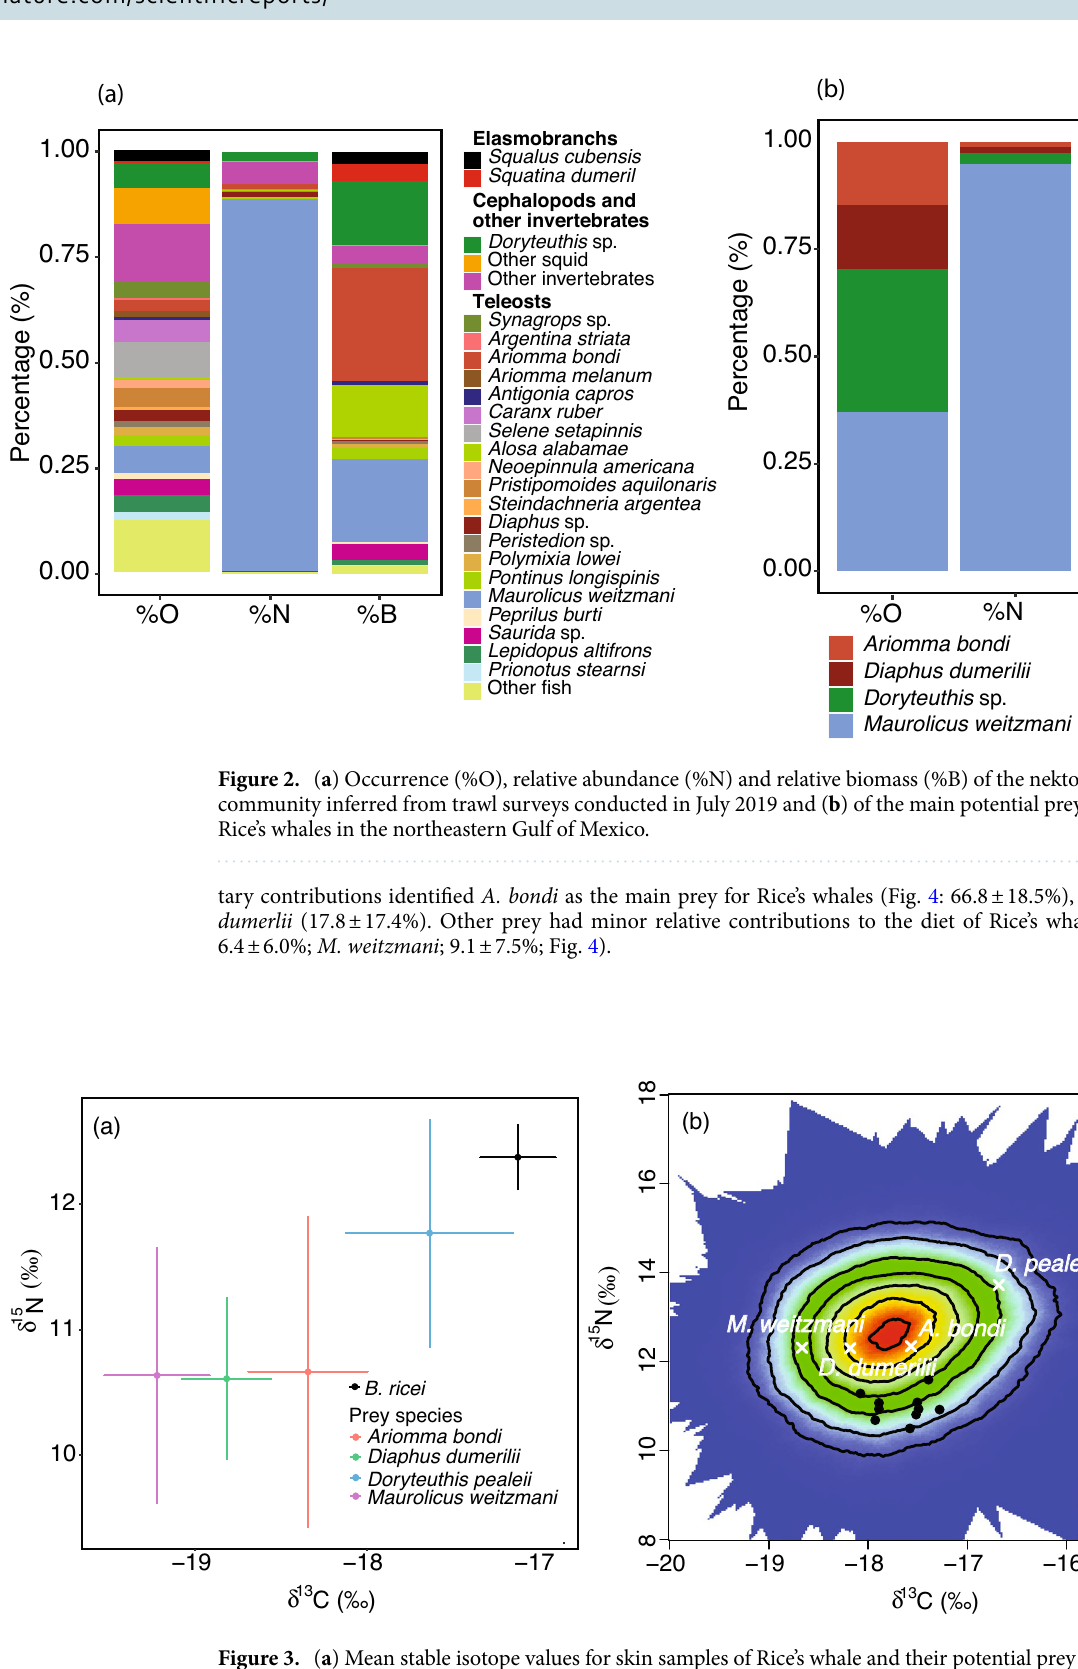
Figure 3. ( a ) Mean stable isotope values for skin samples of Rice’s whale and their potential prey items from the Gulf of Mexico and ( b ) simulated mixing region for the biplot shown in panel ( a ), including the positions of Rice’s whales (black dots) in relation to their prey (white crosses), including the trophic enrichment factor from Borrell et al. 48 (δC = 1.29 ± 0.56; δN = 2.73 ± 0.58). Contours are used to illustrate probabilities within the mixing region at 5% (the outermost contour) and every 10% interval, illustrated using the color scale and contour lines. The 95% mixing region is the area within the 5%